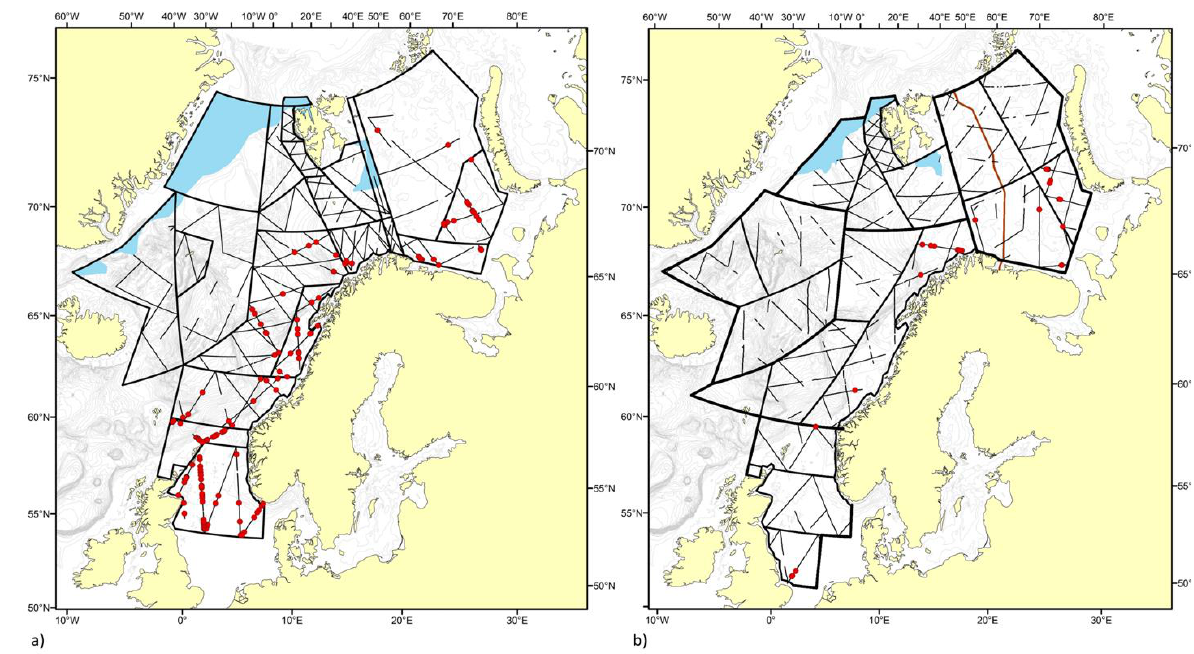
Figure 11. Distributions of sightings recorded as harbour porpoises during (a) the 2002 – 2007 surveys and (b) the 2008 – 2013 surveys. The blue areas represent ice